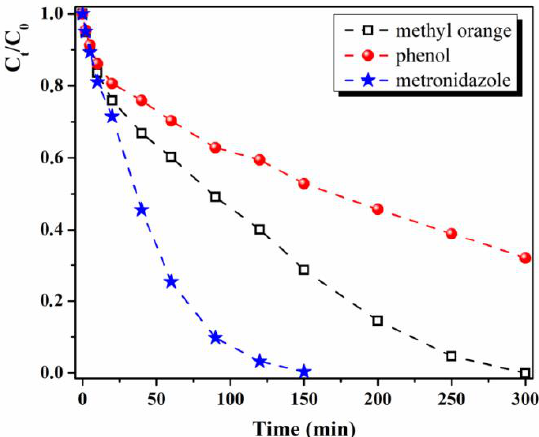
Figure 11. Temporal evolution of reduction efficiencies (C t /C 0 ) of methyl-orange, phenol and metronidazole in the presence of M1-Au film under visible irradiation.